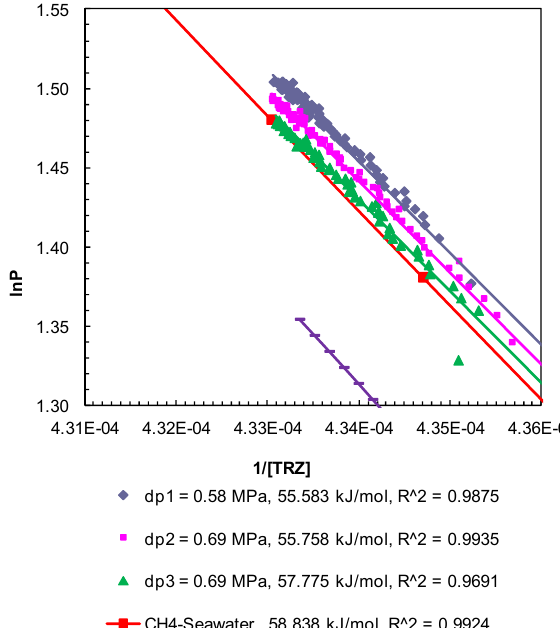
Figure 7. Post-depressurization (dps1–3) P - T conditions from Experiment 3 plotted as ln P against 1/[ T R Z ]. The Clausius-Clapeyron equation was used to calculate enthalpy of dissociation ( ∆ H in kJ/mol) of methane hydrates from seawater in porous media at a hyd confining pressure of 10.44 MPa. The R 2 values indicate the correlation coefficient for linear regression performed to compute the slope as ∆ H hyd